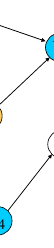
Figure 4. n-hop neighboring nodes of node v1.